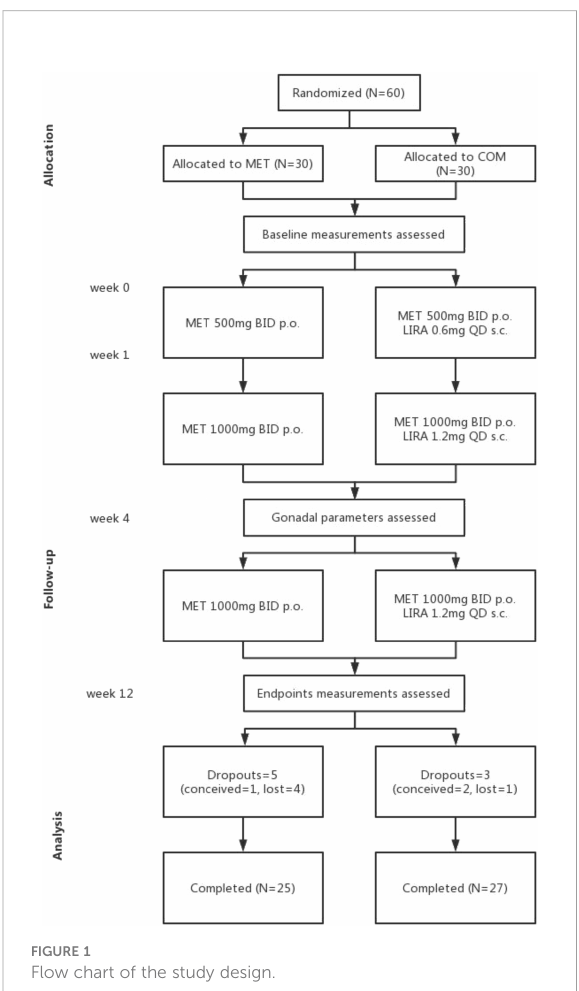
FIGURE 1 Flow chart of the study